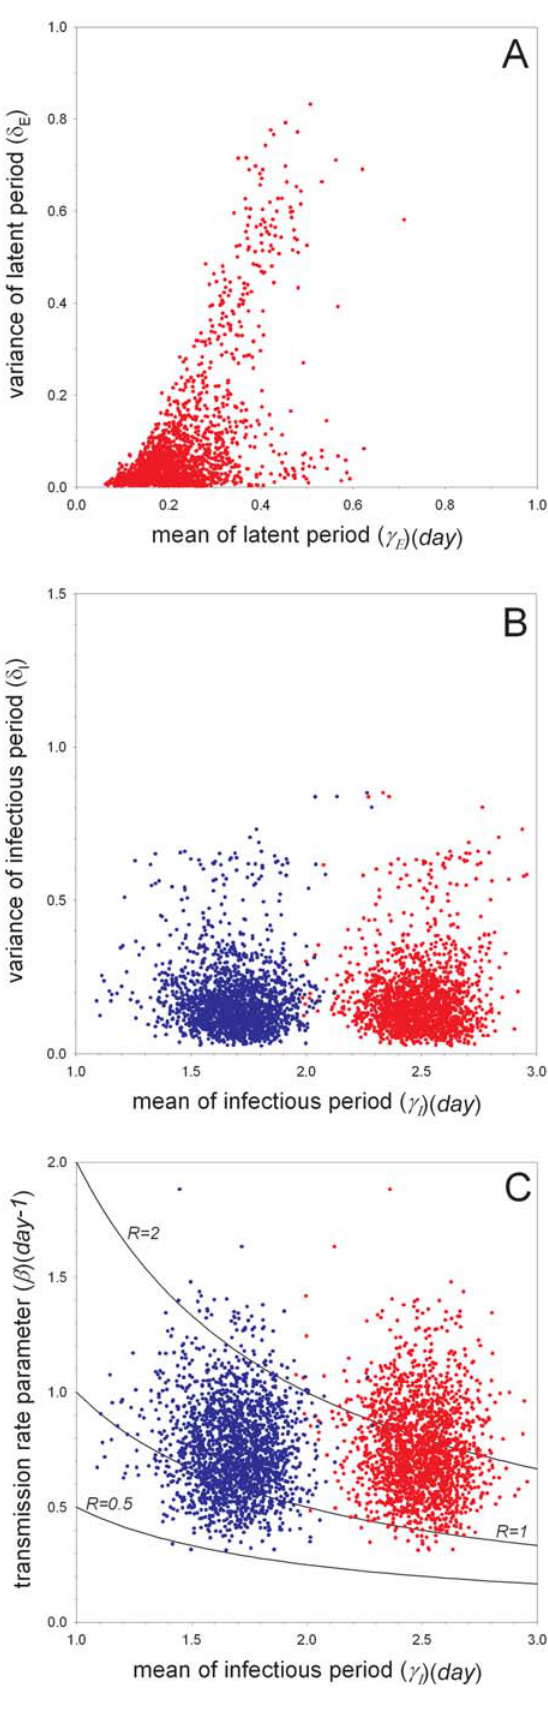
Figure 2. Bayesian analysis of the experiments with unvacci- nated birds (scenario C). Shown are samples from the marginal posterior density of the mean versus variance of the latent period (A), the mean versus variance of the infectious period (B), and the mean infectious period versus transmission rate parameter (C). Blue and red dots refer to parameters characterizing the low- and high-dose experiments, respectively. The contours in (C) correspond to specific values of the reproduction number. See Figure S4 for additional